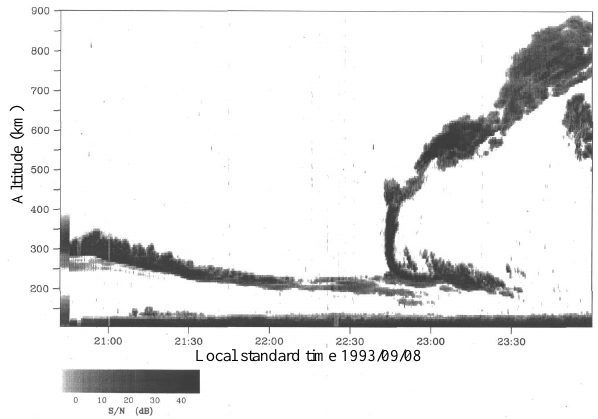
Figure 3. Vertical velocity of plasma irregularities corresponding to Fig. 1.